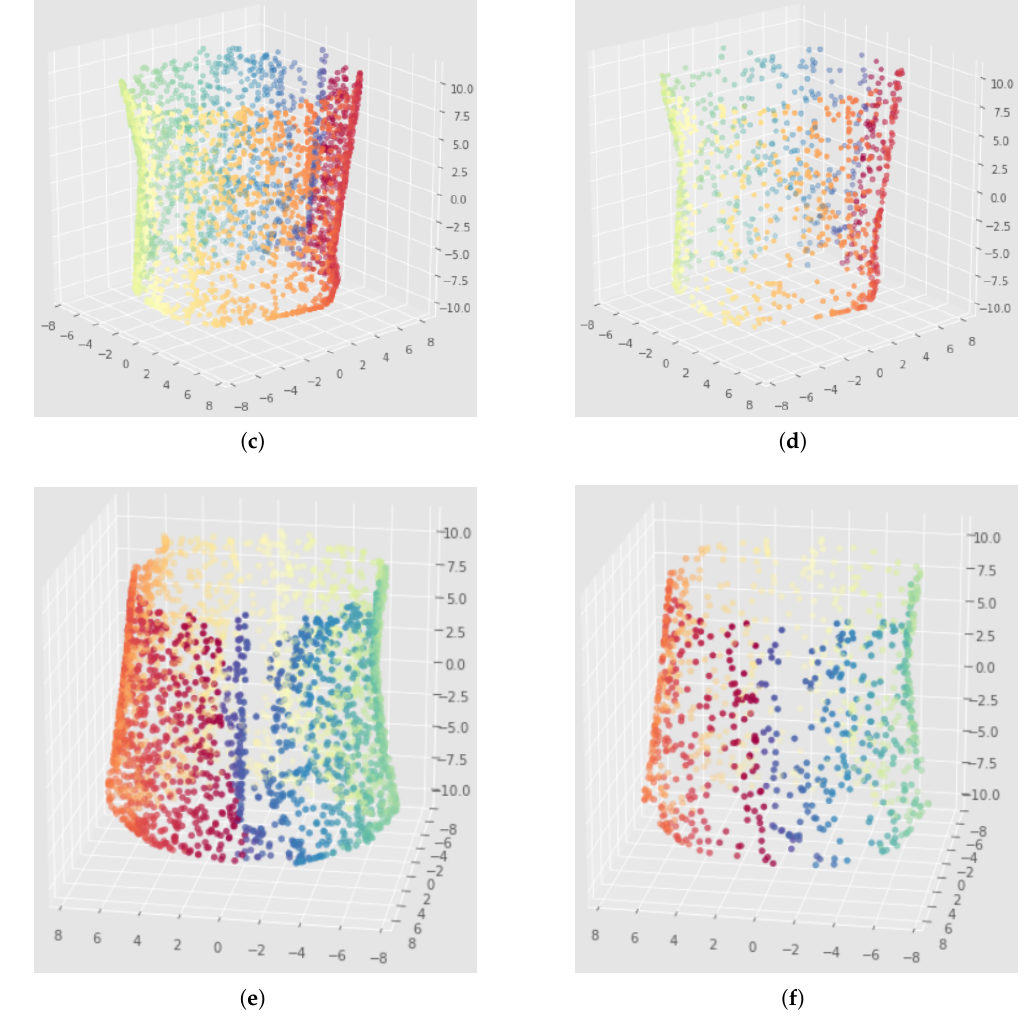
Figure 20. Witness Simplicial VAE applied to the open cylinder after 1000 epochs: training set (left) and test set (right), latent representation (1st row) and reconstruction (2nd and 3rd rows). Hyper parameters: batch size = 128, pytorchseed = 6, 10 landmarks, r filtration = 6, weights w SE = w SD = 10. ( a ) Latent representation (training set). ( b ) Latent representation (test set). ( c ) Reconstruction view 1 (training set). ( d ) Reconstruction view 1 (test set). ( e ) Reconstruction view 2 (training set). ( f ) Reconstruction view 2 (test